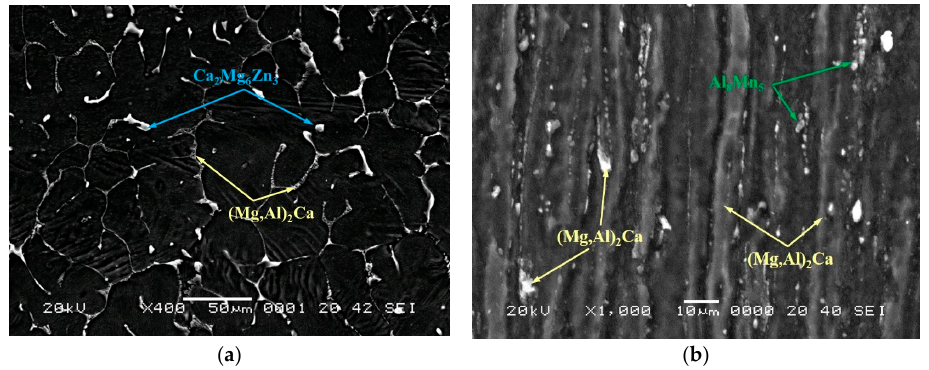
Figure 2. Scanning electron microscope (SEM) initial microstructure of AZ31-2Ca alloy for ( a ) as-cast and ( b ) DMD processed conditions exhibiting intermetallic particles.